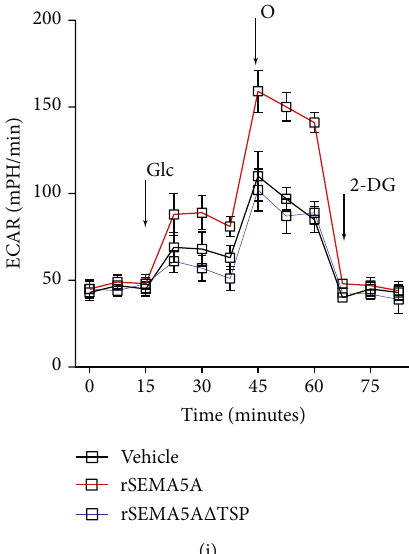
Figure 5: SEMA5A-PLXNB3 axis facilitates the Warburg e ff ects via enhancing glycolysis. (a, b) Relative mRNA level of HIF1A (a) or MYC (b) a ff ected by administration of rSEMA5A or SEMA5A- Δ TSP ( n = 3 repeats per sample; mean ± s : e : m : ; two tailed unpaired t -test). ∗∗ P < 0 : 01 ; ∗∗∗ P < 0 : 001 ; NS: no signi fi cant di ff erence. (c) IF staining in KPC derived ex vivo liver metastasis tissue treated with rSEMA5A or SEMA5A- Δ TSP demonstrating the expression and distributions of HIF-1 α ( n = 5 mice per group, 3 fi elds assessed per sample). HIF1A, green; DAPI, blue; scale bars, 50 μ m. (d, e) Metabolism level alterations of PANC1 and BxPC3 cell lines a ff ected by SEMA5A- PLXN3 axis were assessed by relative glucose consumption (d) and lactate production (e) ( n = 5 repeats per group, mean ± s : e : m : ; two tailed unpaired t -test). ∗ P < 0 : 05 ; ∗∗ P < 0 : 01 ; ∗∗∗ P < 0 : 001 . (f, g) The expression alteration of key enzymes involved in glycolysis pathway in PANC1 (f) and BxPC3 (g) after stimulation by rSEMA5A or SEMA5A- Δ TSP exposure ( n = 3 repeats per group, mean ± s : e : m : ; two tailed unpaired t -test). ∗ P < 0 : 05 , ∗∗ P < 0 : 01 , and ∗∗∗ P < 0 : 001 for rSEMA5A group; # P < 0 : 05 , ## P < 0 : 01 , and ∗∗∗ P < 0 : 001 for SEMA5A- Δ TSP group; NS: no signi fi cance. (h, i) Relative ECARs in PANC1 (h) or BxPC3 (i) treated with rSEMA5A or SEMA5A- Δ TSP measured by seahorse system ( n = 3 repeats, mean ± s : e : m :